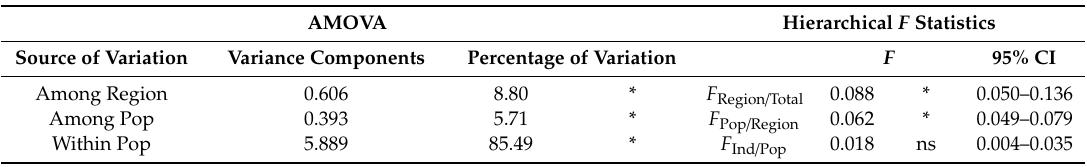
Table 3. Hierarchical analysis of genetic structure using analysis of molecular variance (AMOVA) and hierarchical F